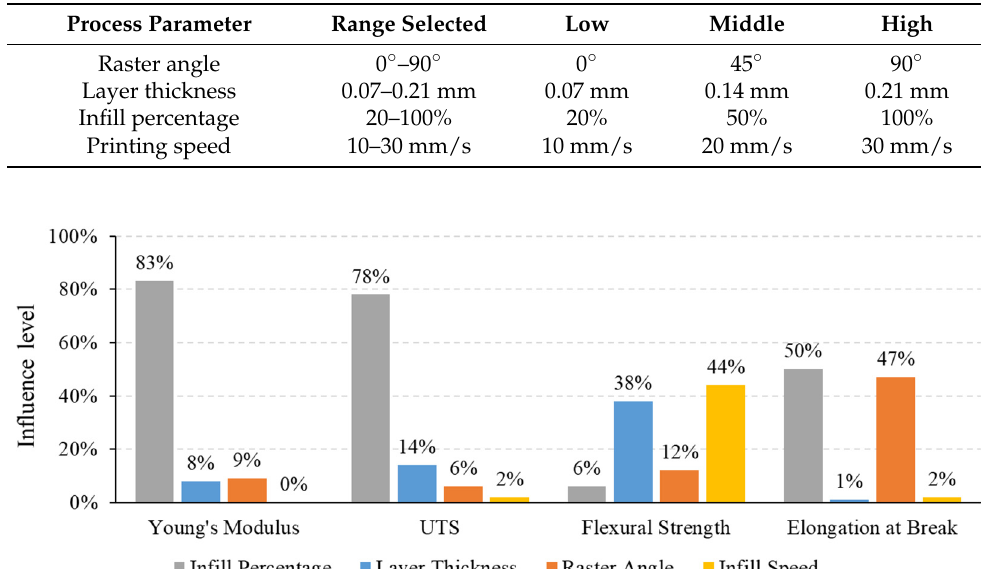
Table 6. Process parameters range used for PEEK material along with the related settings.